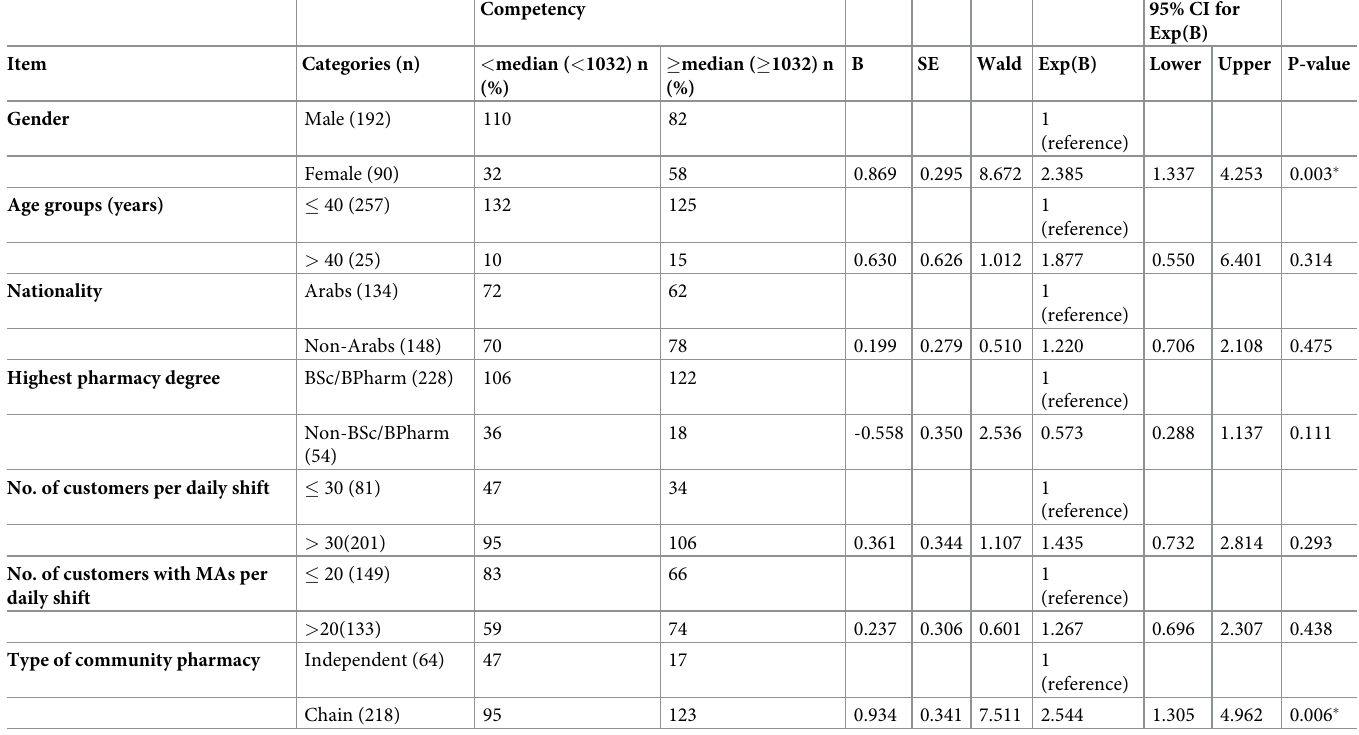
NB: 1032 (median score) is the cutoff point for self-perceived competency (maximum is 1290); MAs = Minor ailments B = Coefficient; SE = Standard Error; Exp(B) = Exponentiation of coefficient; CI = Confidence Interval � p < 0.05 (statistically